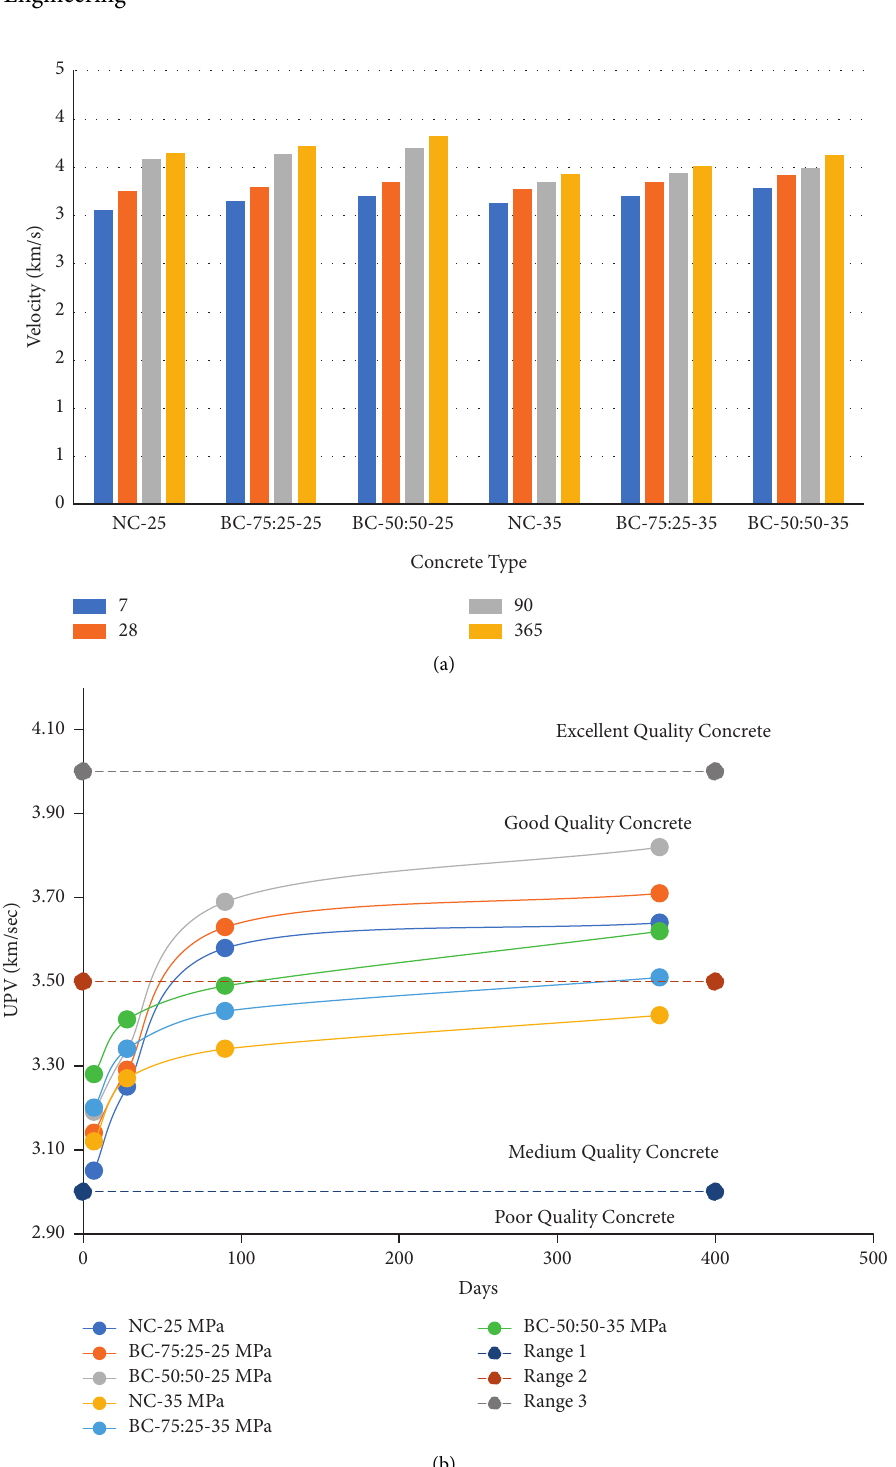
Figure 6: Variation of UPV test results and curing periods for 25MPa concrete and 35MPa